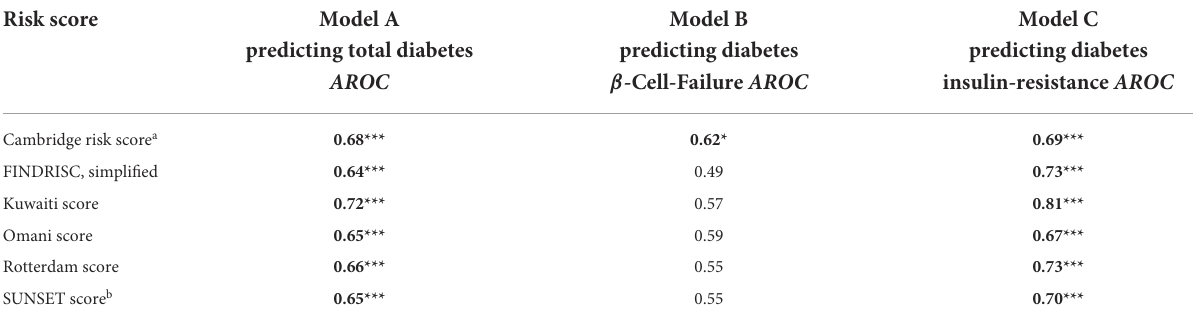
TABLE 3 Area under the receiver operator characteristic curve for predicting type 2